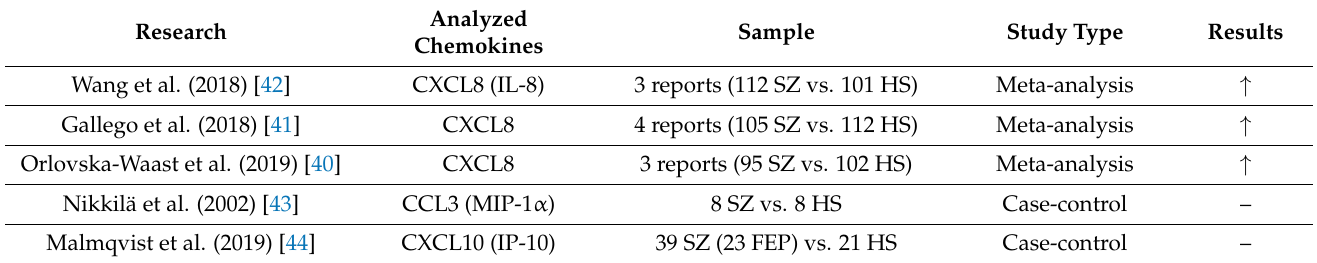
Table 3. Available data on the level of chemokines in the cerebrospinal fluid of patients with SZ and